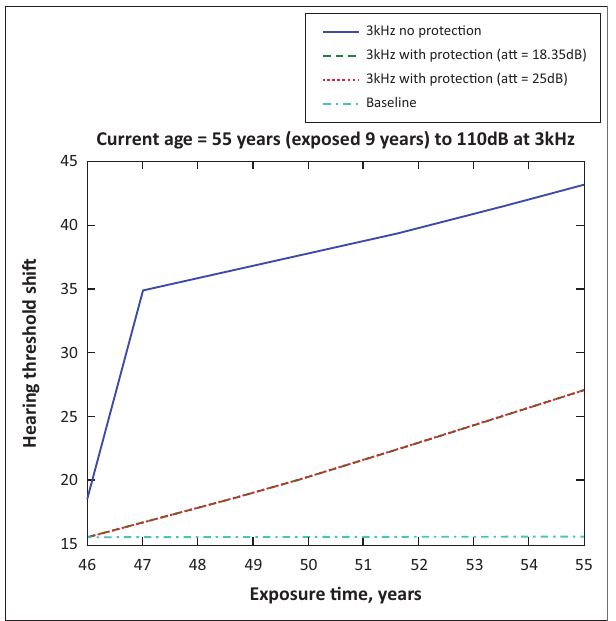
Source : Figure created using data from Moroe, N.F. (2018). Occupational noise-induced hearing loss in South African large scale mines: From policy formulation to implementation and monitoring . Doctoral thesis. Johannesburg: University of the Witwatersrand. FIGURE 13: Fifty-one years old at 4000 Hz with exposure levels of 105 dB.